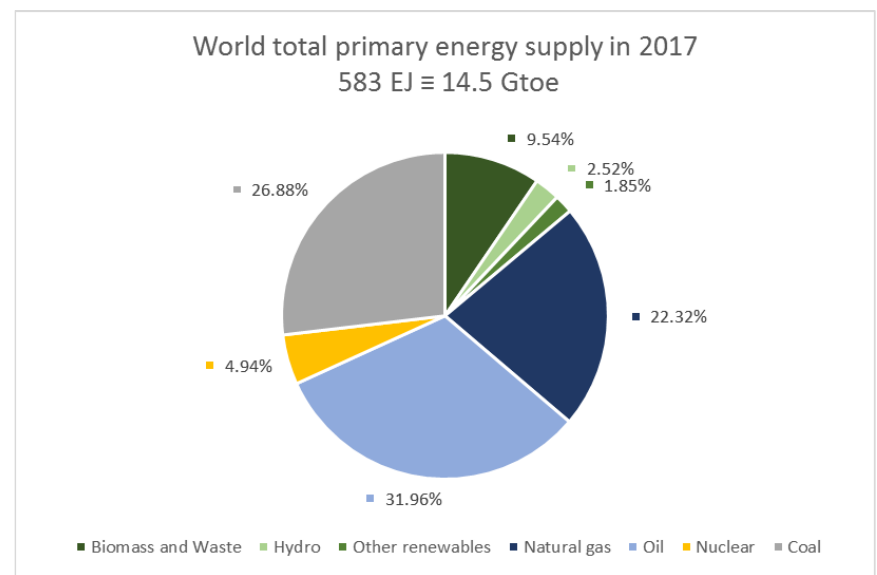
Figure 1. World total primary energy supply in 2017 detailed by fuel. Peat and oil shale are aggre- gated with coal and the label “Other” includes geothermal, solar, wind, heat, etc., [2].